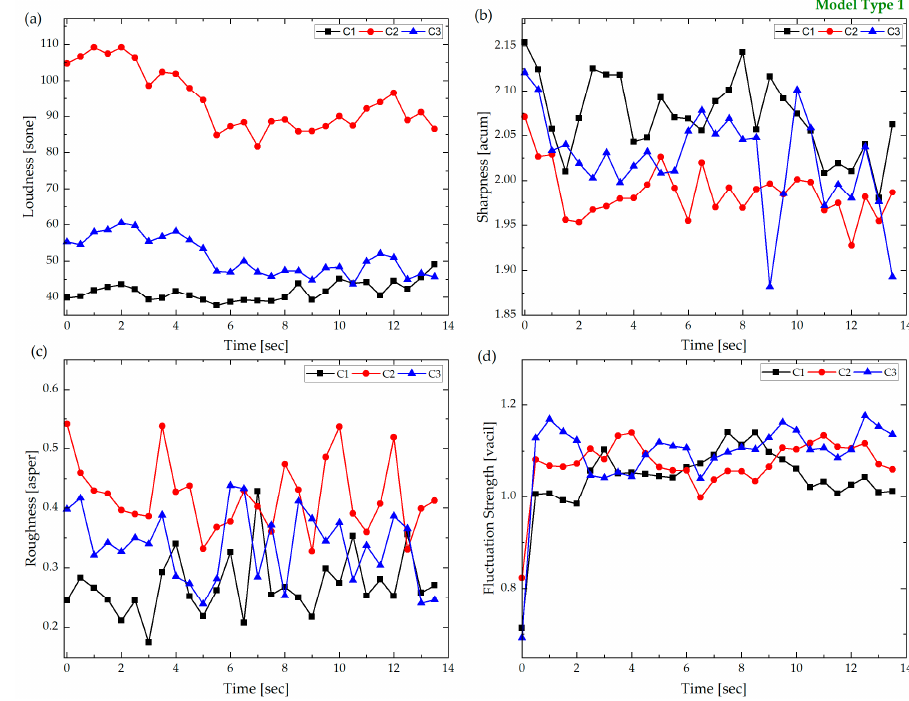
Figure 3. Psychoacoustic parametric values for the vacuum cleaner (model type 1). ( a ) Loudness, ( b ) sharpness, ( c ) roughness, and ( d ) fluctuation strength.